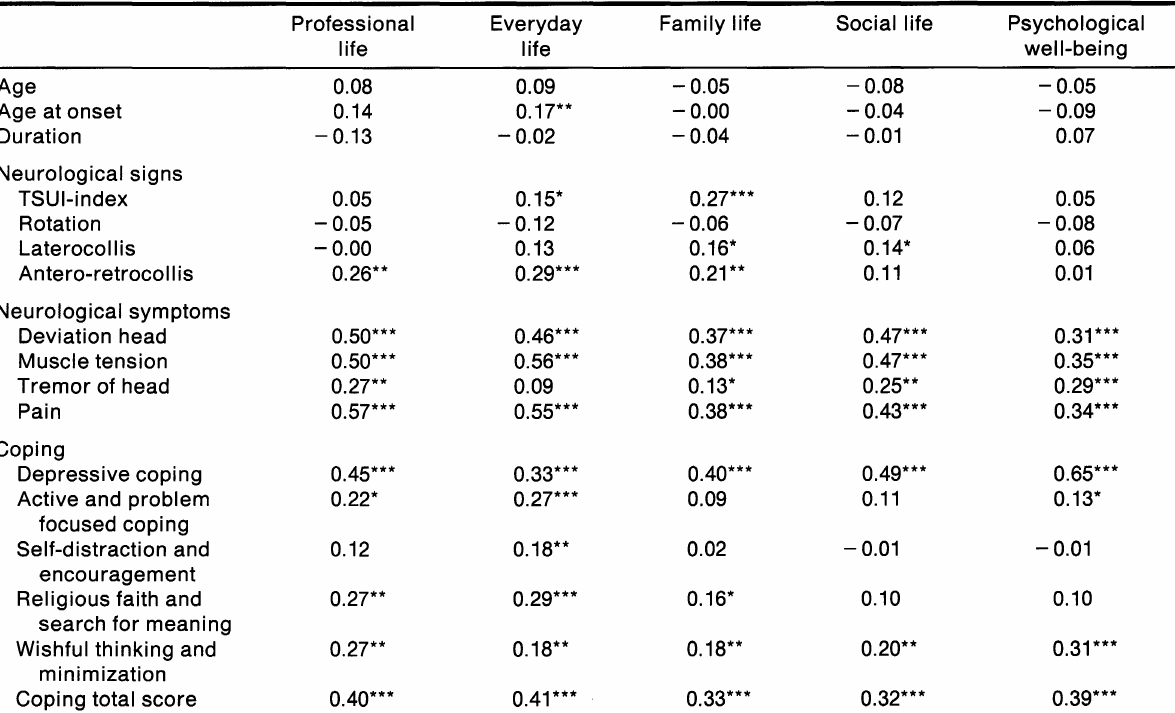
TABLE I. Correlations between psychosocial changes (scales of the FaD) signs (neurological assessment) symptoms (self-reported) and coping (FKV)